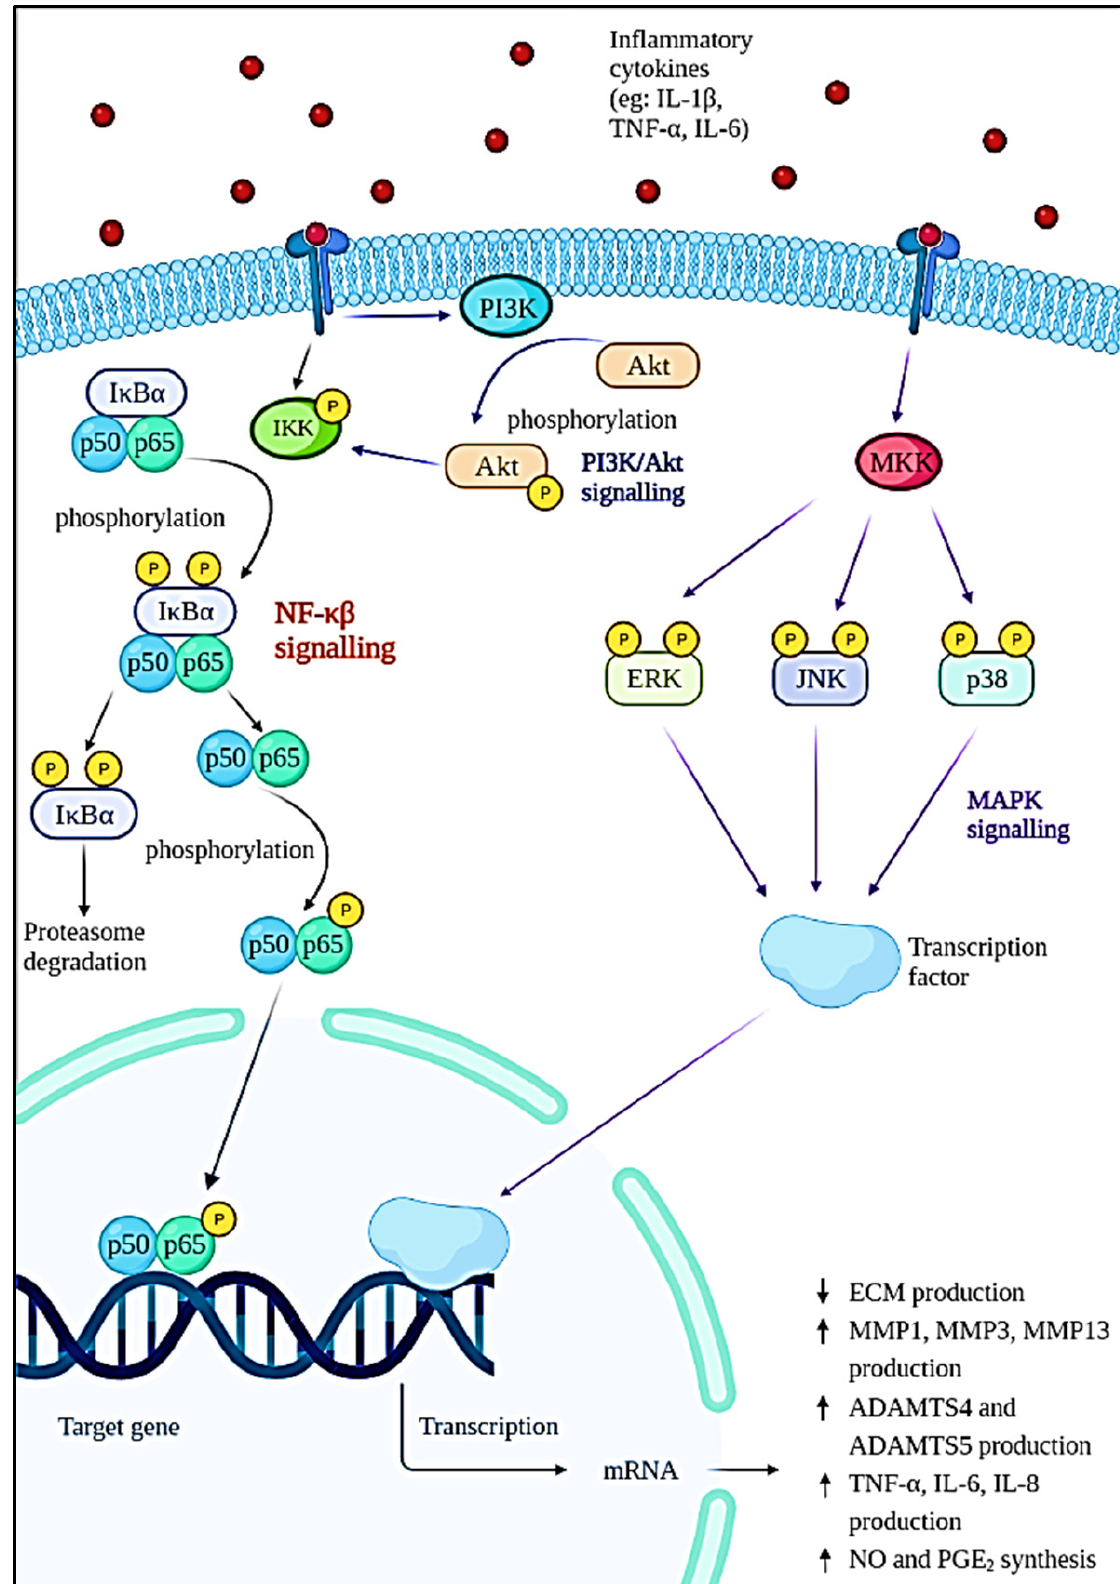
Figure 2. Intracellular signaling pathways and downstream effects involved in the progression of OA.